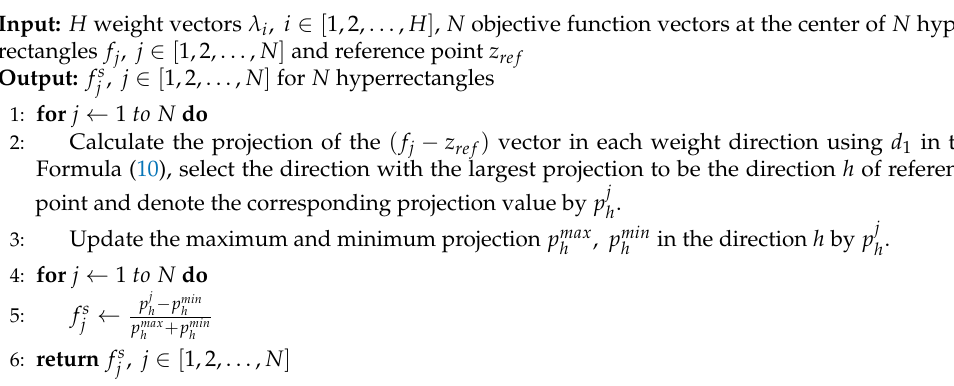
Algorithm 4 Generation procedure of the decomposition based